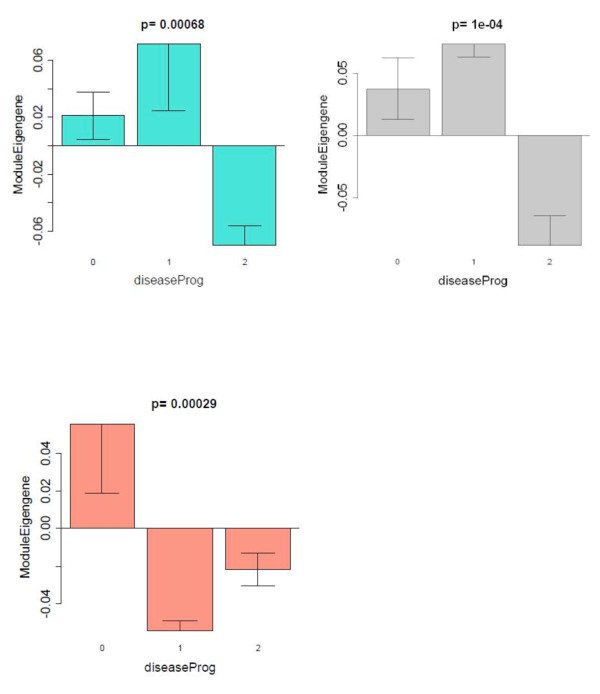
Primary Sjögren's syndrome disease-related co-expression modules that are downregulated in primary Sjögren's syndrome patients. Barplots analogous to those described in Figure 2. The module eigengenes of two modules - Turquoise (3,981 genes) and Grey (3,011 genes) - are significantly underexpressed in primary Sjögren's syndrome (pSS) patients compared with both non-pSS sicca patients and controls. Note that the Salmon module (446 genes) differs from the other two modules with respect to the non-pSS sicca patients, where the module eigengene is underexpressed compared with controls.